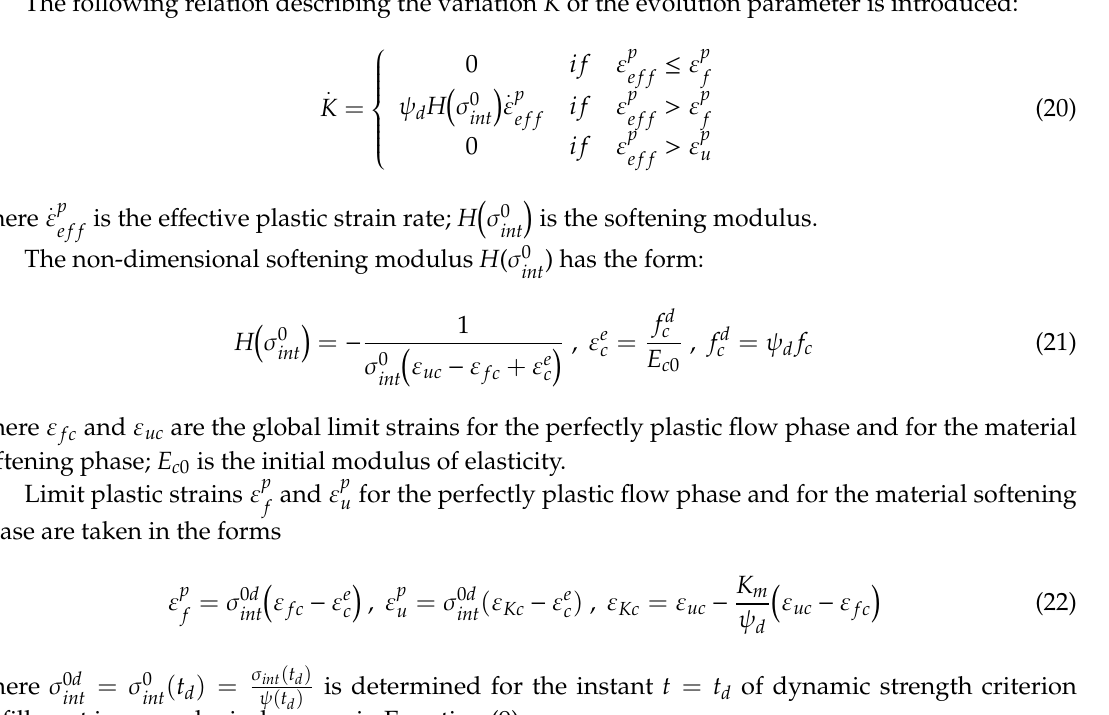
Figure 2. Evolution parameter: ( a ) dynamic strength criterion integration method during variable stressing process; ( b ) scheme of attaining the initial dynamic yield surface; ( c ) variation of evolution parameter for uniaxial compression depending on global strains; ( d ) variation of evolution parameter for uniaxial compression depending on effective plastic strains.